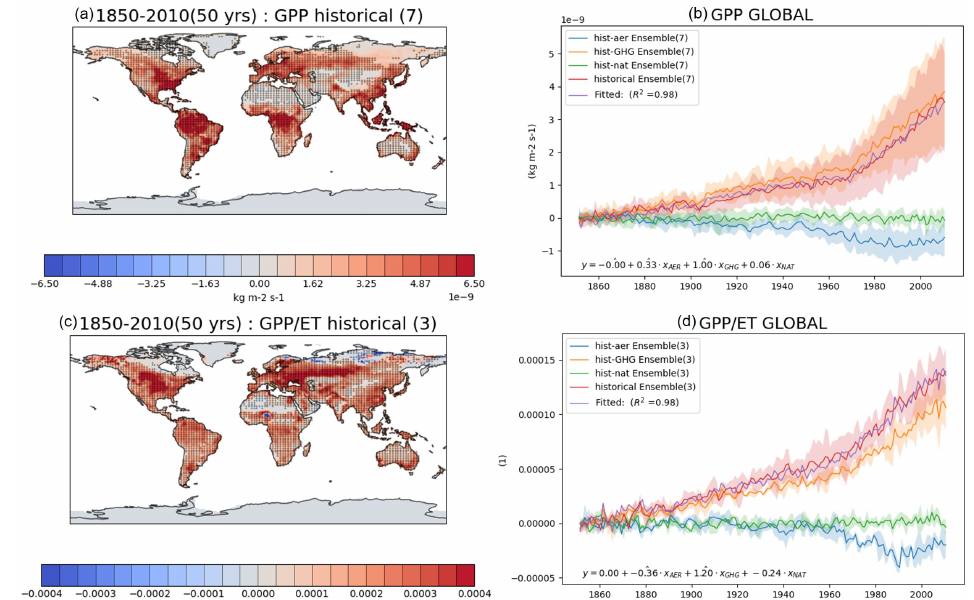
Figure 8. Results of the GPP and WUE analysis: ( a ) 50-year mean start-to-end difference in GPP (1850-2010); ( b ) time series plot of global GPP; ( c ) 10-year mean start-to-end difference in WUE (1870–2010); ( d ) time series plot of global WUE. The titles above the plots and the legends within the plots are followed by the number of ensemble models in parentheses, and the estimated parameters with hats provide statistical significances. On the maps, dots indicate where the differences are significant ( p -value ≤